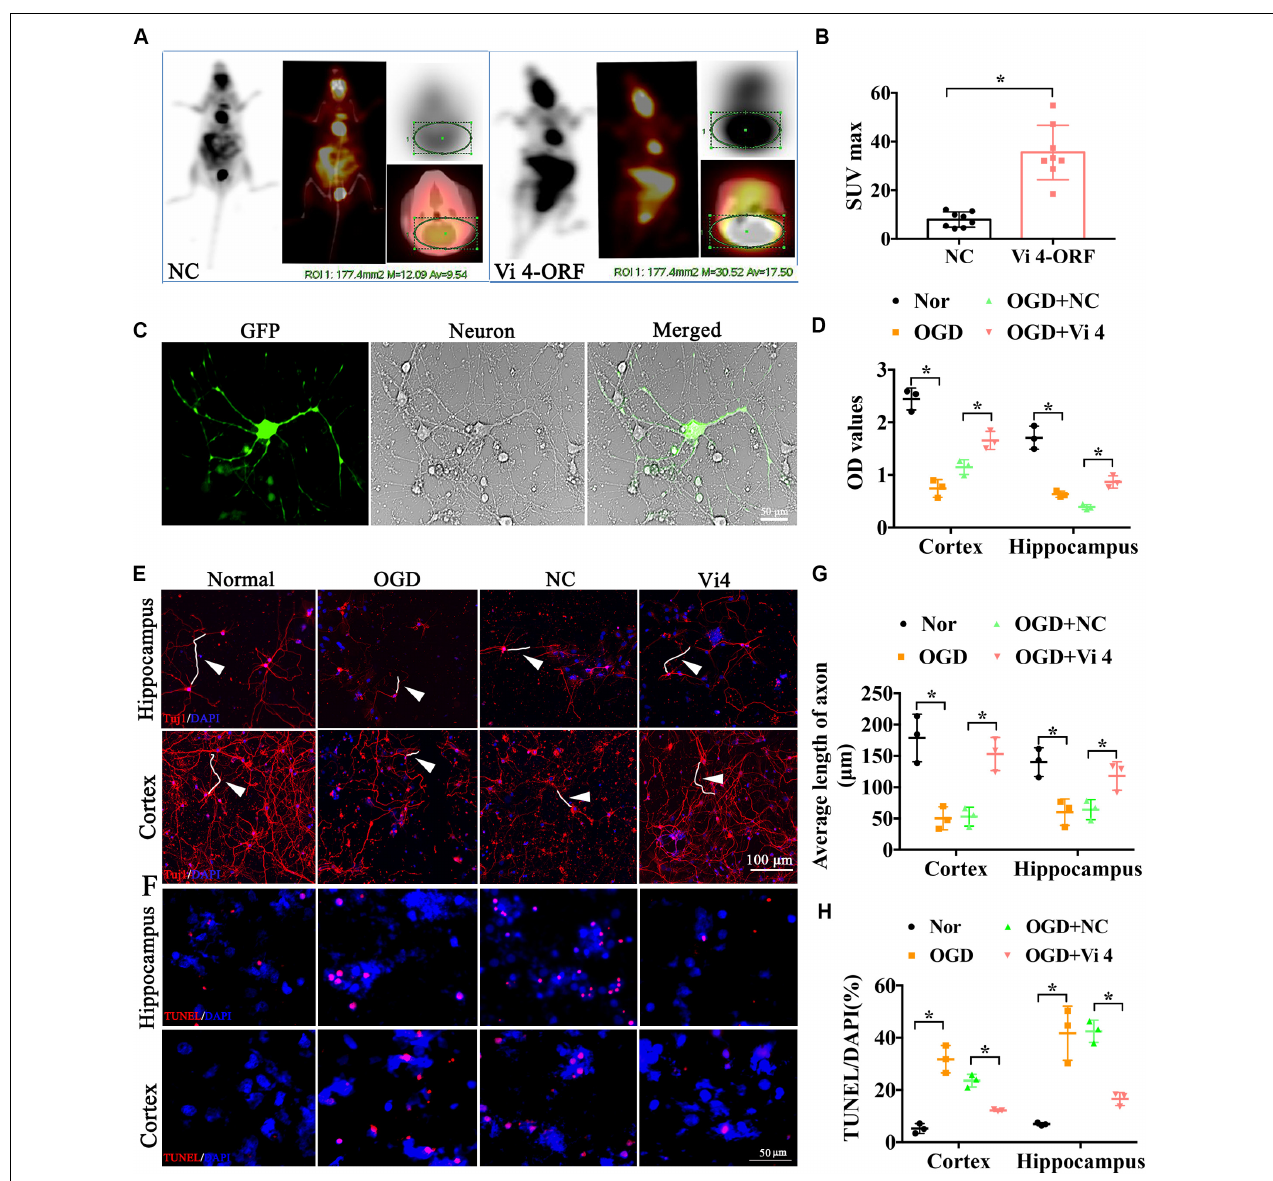
FIGURE 3 | The functional examination on the hippocampal and cortical neurons after the transfection of the Vi4-ORF. (A) Images of glucose uptake in the brain by PET-CT in NC and Vi4-ORF groups 2-month after HI. (B) The quantified bar chart of SUV max, n = 8/group. (C) The successful transfection of Vi4-ORF vectors in the cortical neurons, demonstrated by green fluorescence in the cells. Scale bar = 50 µ m. (D) Cell viability showed by relative CCK8 values in both normal and OGD cells with lentivirus transfection 24 h after OGD in hippocampal and cortical neurons. (E) Immunofluorescent staining of Tuj1 to observe the cell state after the ORF-Vi4 vector transfection in the hippocampal and cortical neurons 24 h after OGD. Red fluorescence represents the positive Tuj1 cells, and the blue is the nuclear staining. White arrow represents axon. Scale bar = 100 µ m. (F) Cell apoptosis detected by TUNEL staining in the cortical neurons 24 h after OGD. Scale bar = 100 µ m. Red fluorescence represents TUNEL positive cells, and the blue is the nuclear staining. (G) Bar chart for average axon length of cortical and hippocampal neurons at 24 h post OGD. (H) Cell apoptosis presented by TUNEL/DAPI (%) in both normal and OGD cells with lentivirus transfection 24 h after OGD. PET-CT, Positron Emission Tomography-Computed Tomography; SUV, Standardized Uptake Value; OGD, oxygen glucose deprivation; Tuj1, neuronal class III β -Tubulin; CCK8, cell counting kit-8; TUNEL, Terminal deoxynucleotidyl Transferase Mediated Nick End Labeling. All data are presented as mean ± SD, * P < 0.05, n =